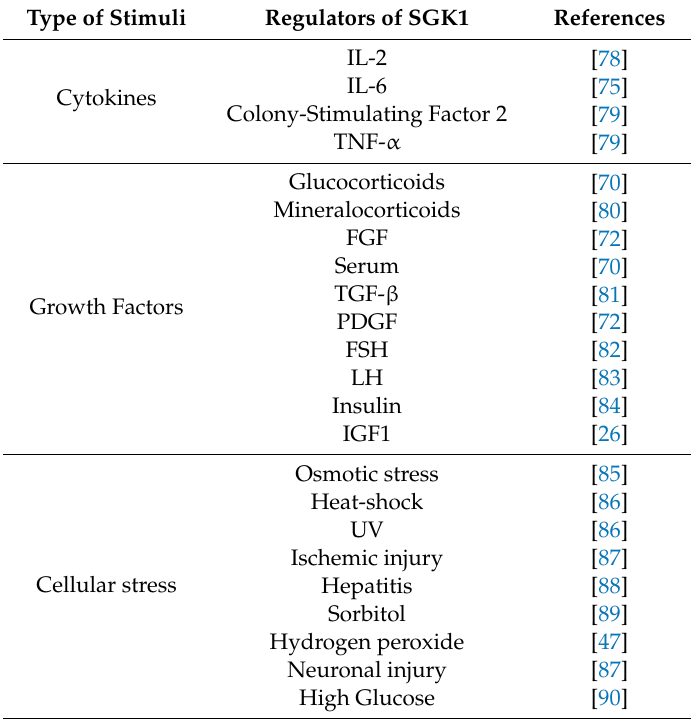
Table 1. Known regulators of SGK1 expression and activity. Abbreviation: Interleukin-2 (IL-2), Internleukin-6, tumor necrosis factor alpha (TNF- α ), Fibroblast growth factor (FGF), Transforming growth factor beta (TGF- β ), Platelet-derived growth factor (PDGF), Follicle-stimulating hormone (FSH), Luteinizing hormone (LH), Insulin-like growth factor 1